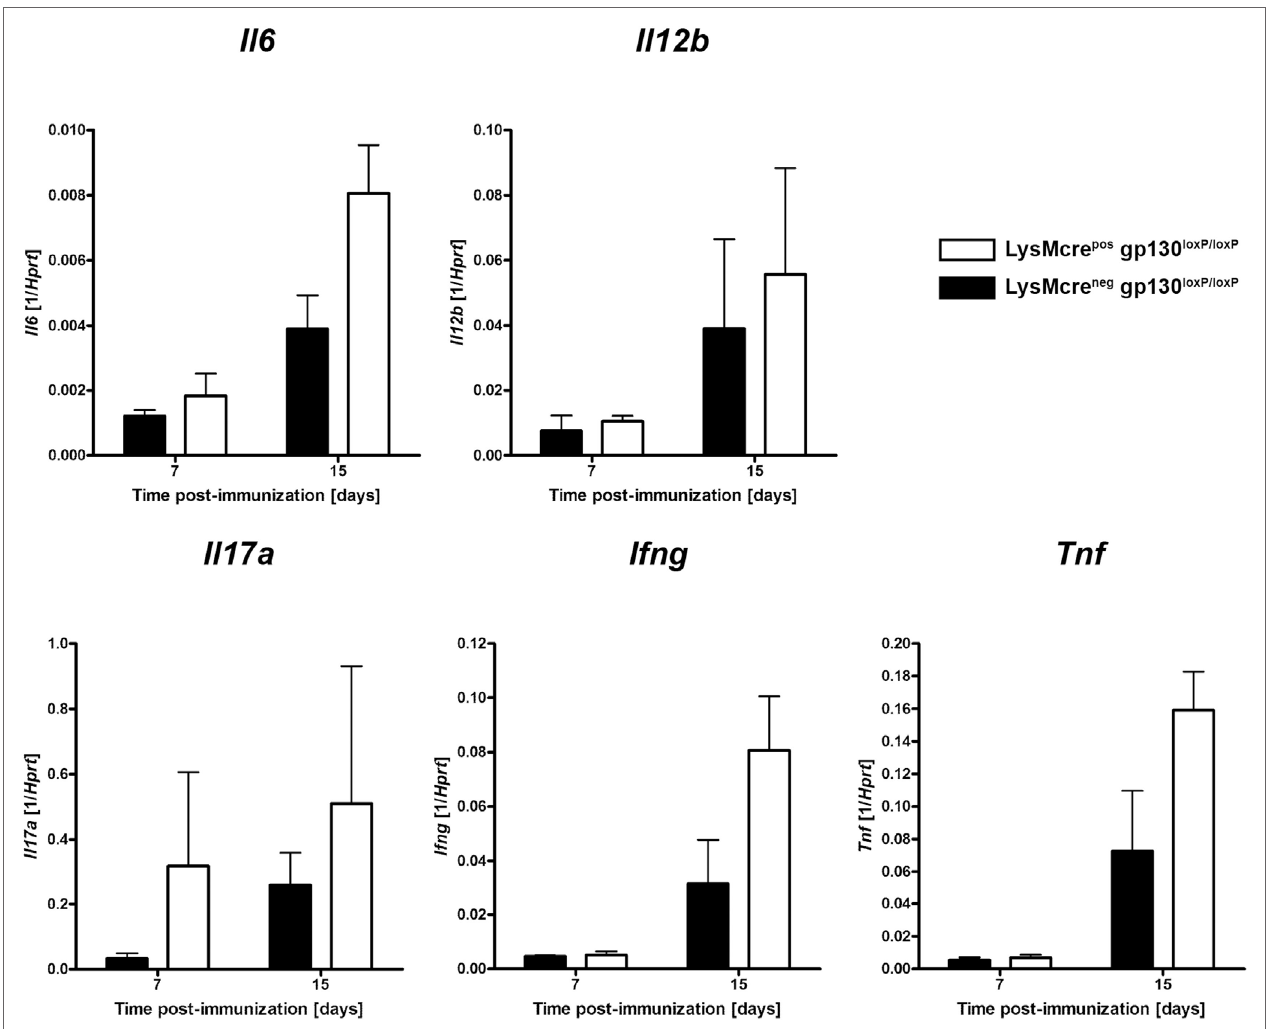
FigUre 8 | Expression of cytokines during the course of EAE. Immunized LysMcre pos gp130 loxP/loxP mice (white bars) show enhanced expression of Il6 , Il12b , Ifng , Il17a , and Tnf compared with LysMcre neg gp130 loxP/loxP littermates (black bars). At different time points after EAE induction, CNS homogenates were assayed for gene expression by quantitative real-time RT-PCR. Data are expressed as ratio of induced factors versus endogenous Hprt and expressed as means and SEs of three mice per group. Statistical analysis was performed using Mann–Whitney